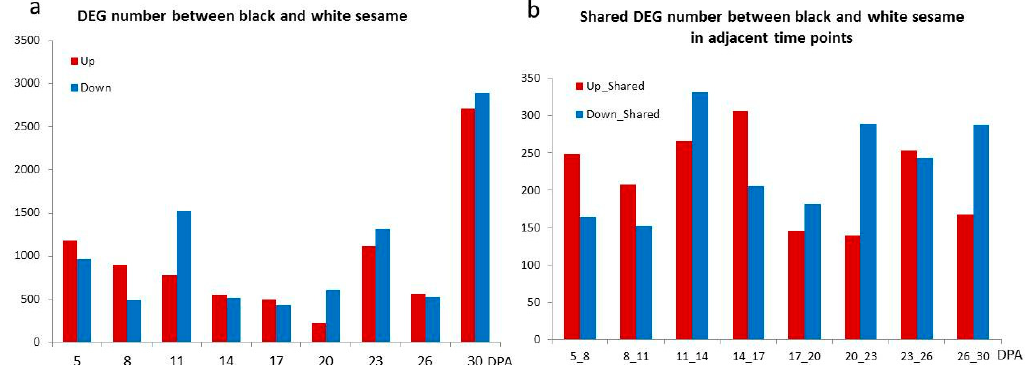
Figure 5. The di ff erentially expressed genes between black and white sesame at di ff erent stages. ( a ) DEG number between black and white sesame. ( b ) The shared di ff erentially expressed genes Figure 5. The differentially expressed genes between black and white sesame at different stages. ( a ) between black and white sesame at two contiguous DEG number between black and white sesame. ( b ) The shared differentially expressed genes between black and white sesame at two contiguous stages.